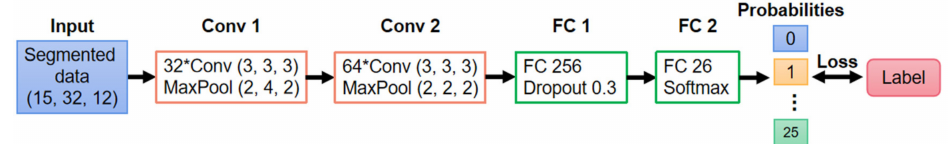
Figure 5. Classification model for raw data as input.